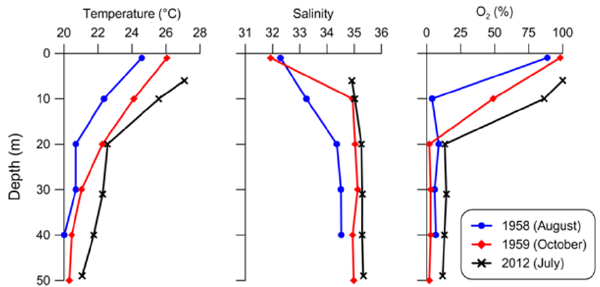
Figure 16. Comparison of historical profiles of temperature, salinity and dissolved oxygen corresponding to peak upwelling months over the inner shelf off Kochi, southwest coast of India (From Gupta et al.,